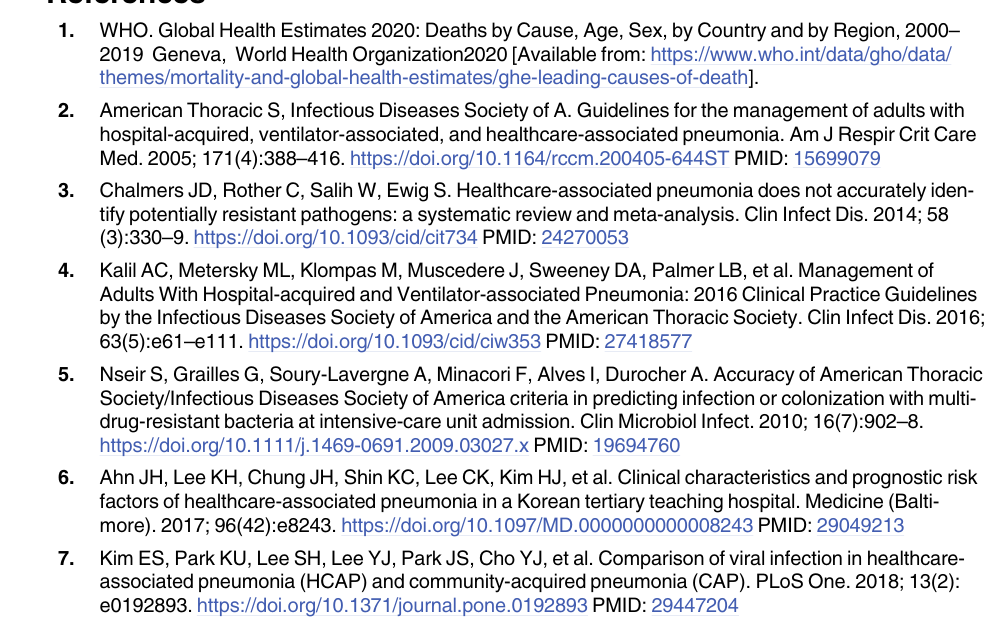
S2 Table. Comparison of antibiotic resistance and clinical outcomes between long-term care facility onset healthcare-associated pneumonia and community-onset healthcare- associated pneumonia. S3 Table. Comparison of standard antibiotic susceptibility for isolated bacterial patho- gens † between CAP and HCAP subgroups. S4 Table. Comparison of antibiotic treatment regimens for